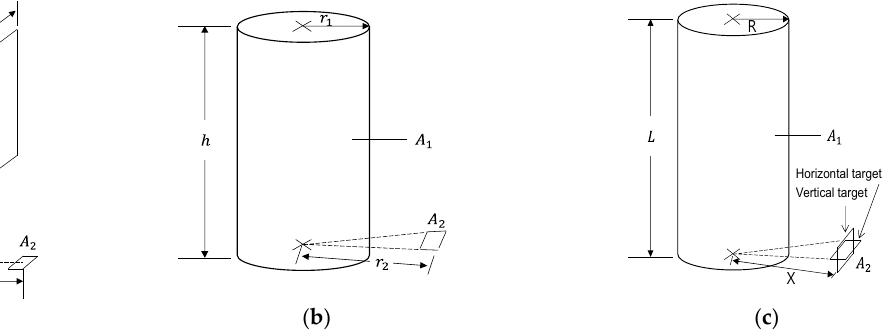
Figure 7. Configuration factor geometry: ( a ) vertical rectangular flame shape; ( b ) cylindrical flame shape; ( c ) cylindrical flame shape indicated in ISO 24678-7.